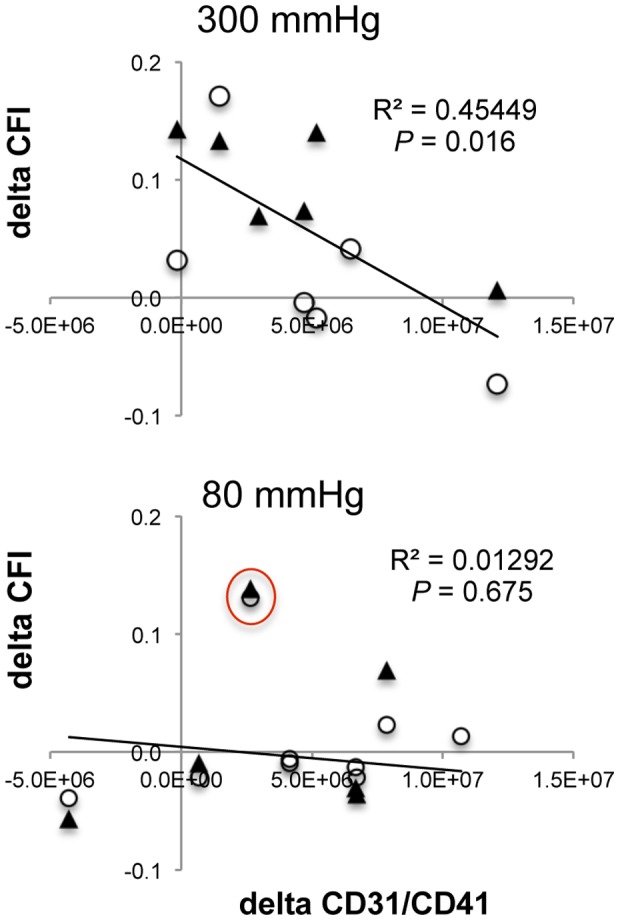
Correlation of PMP and CFI changes.Plotted values are the differences between follow-up and baseline measurements with platelet-derived microparticle positive for CD31CD41 on the horizontal axis and collateral flow index (CFI) on the vertical axis. Values are given for ECP therapy at high (300 mmHg) on top or low inflation pressure (80 mmHg) at bottom, respectively. Filled triangles represent CFI values from stenosed and open circles from normal vessels. The same correlations were detected with MPs stained positive with CD31 or CD41 alone (Figure S1). The values encircled in red in the 80 mmHg inflation pressure group belong to patient #14.